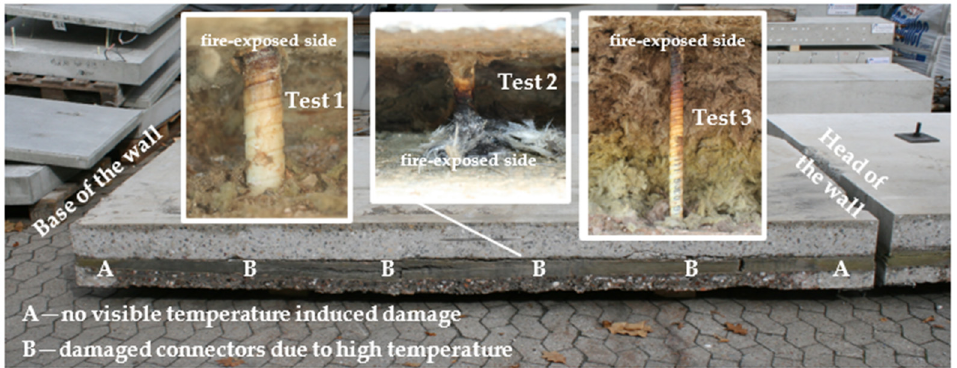
Figure 10. Location of the melted connectors in the cut sandwich wall after fire tests—example of Specimen 2 and typical damage state of connectors.